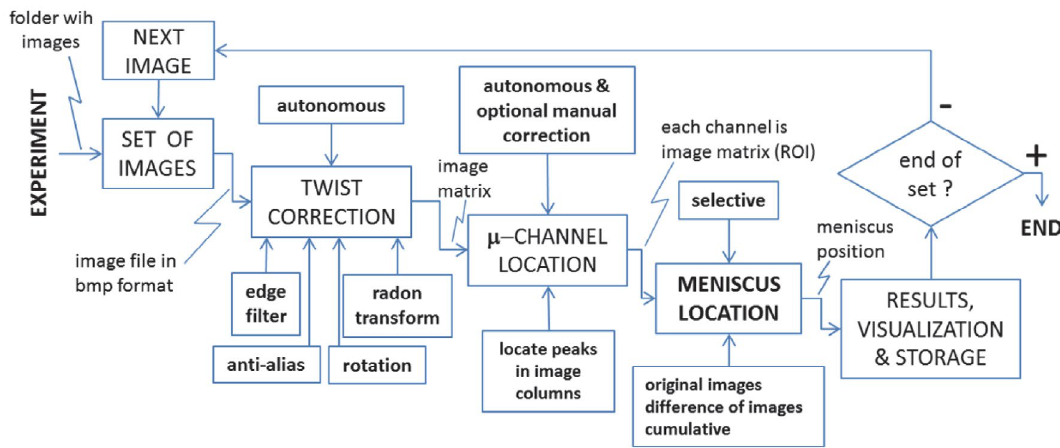
Figure 3. Functional diagram of the digital image sequence